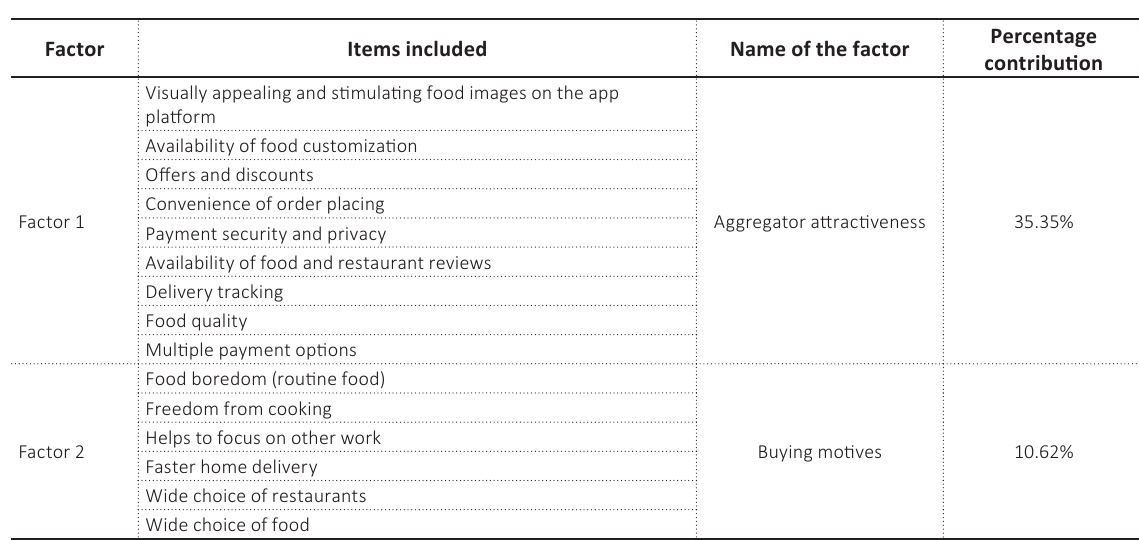
Table 10. Construct wise factor loadings